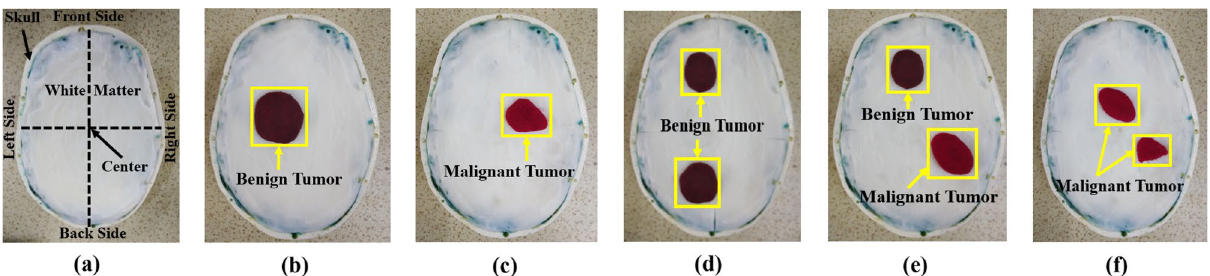
Figure 23. The fabricated phantom model includes tumors at different locations: ( a ) Skull model filled with fabricated tissues; ( b ) With a single benign tumor; ( c ) With a single malignant tumor; ( d ) With two benign tumors; ( e ) With a single benign and a single malignant tumor; (f) With two malignant